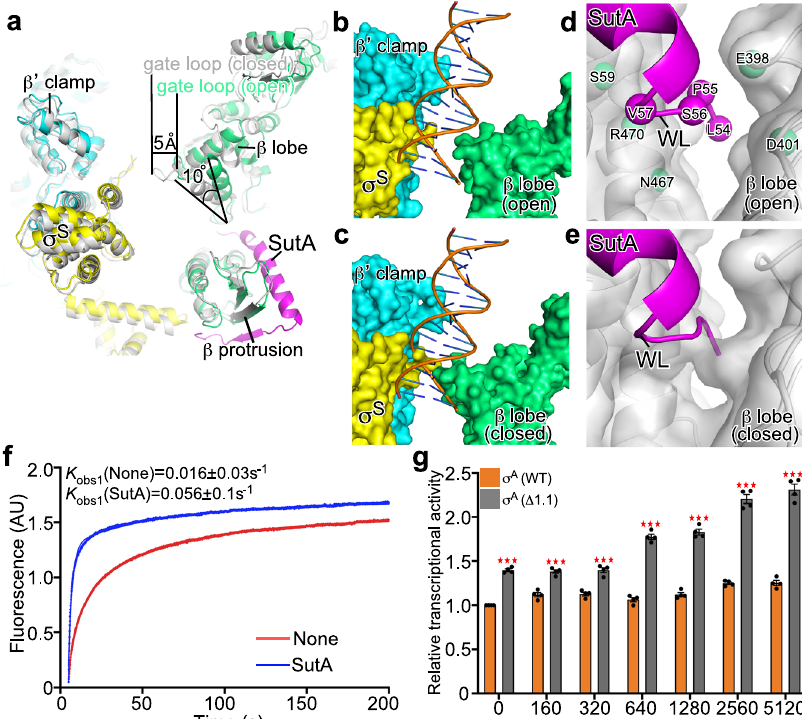
Fig. 5 SutA widens the DNA cleft by opening β lobe. a Structural superimposition between SutA-RNAP- σ S (open lobe; colored as above) and RNAP- σ S holoenzyme (gray) shows 10° opening of β gate loop and 5 Å increase in width of the RNAP main cleft. b Structure modeling shows that dsDNA is able to enter into the main cleft of SutA-RNAP- σ S (open lobe) with little steric hinderance. c The closed lobe in RNAP- σ S holoenzyme imposes a severe steric clash with dsDNA. d The wedge loop of SutA invades into the gap of RNAP- β protrusion/lobe in SutA-RNAP- σ S (open lobe). Spheres highlight the C α atoms of residues that are likely involved in interactions of SutA-WL and RNAP- β protrusion/lobe. WL, wedge loop. e Structure modeling shows that the wedge loop of SutA encounters steric hindrance with the β lobe domain in closed conformation of RNAP- σ S holoenzyme. f The representative curves show SutA increases RPo formation equilibrium analyzed by a stopped- fl ow assay. g The results of fl uorescence-based in vitro transcription assay show that SutA increases rrn promoter transcription by RNAP- σ A or RNAP- σ A ( Δ 1.1) holoenzymes. The data were presented as mean±S.E.M., n = 4. Two-sided Student ’ s t test was performed. The individual data points were shown in black dots. * p < 0.05, ** p < 0.01, *** p < 0.001, n = 4. Source data are provided as a Source Data fi